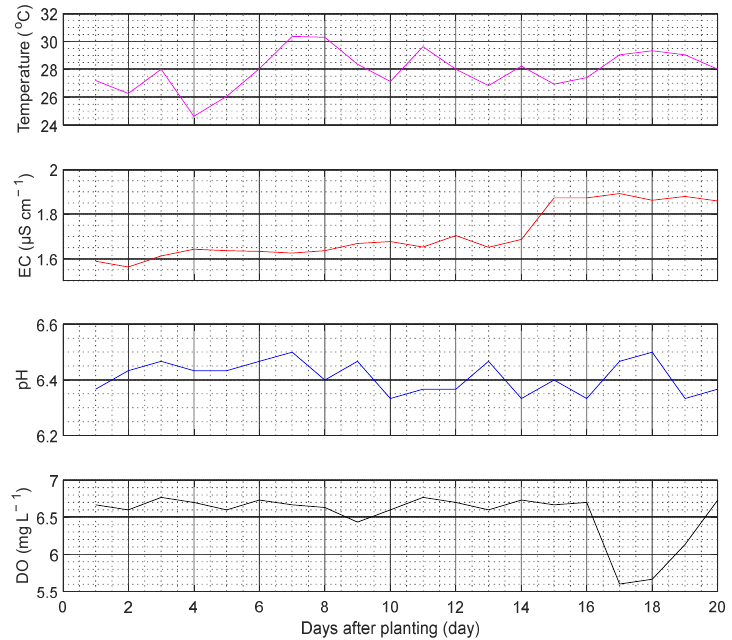
Figure 4. Fertigation quality during spinach cultivation using a hydroponic kit.